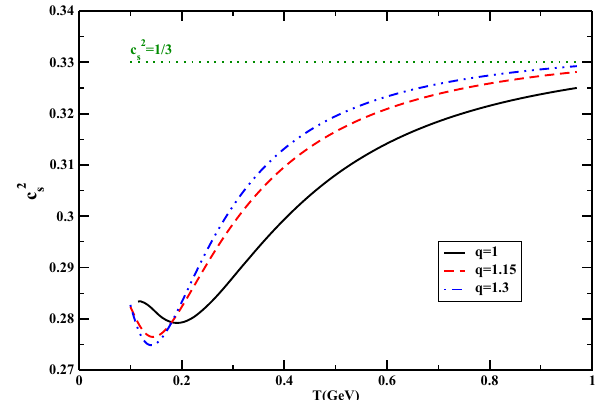
Fig. 6 Relative correction of non-extensive part using BE/FD distri- bution over Boltzmann